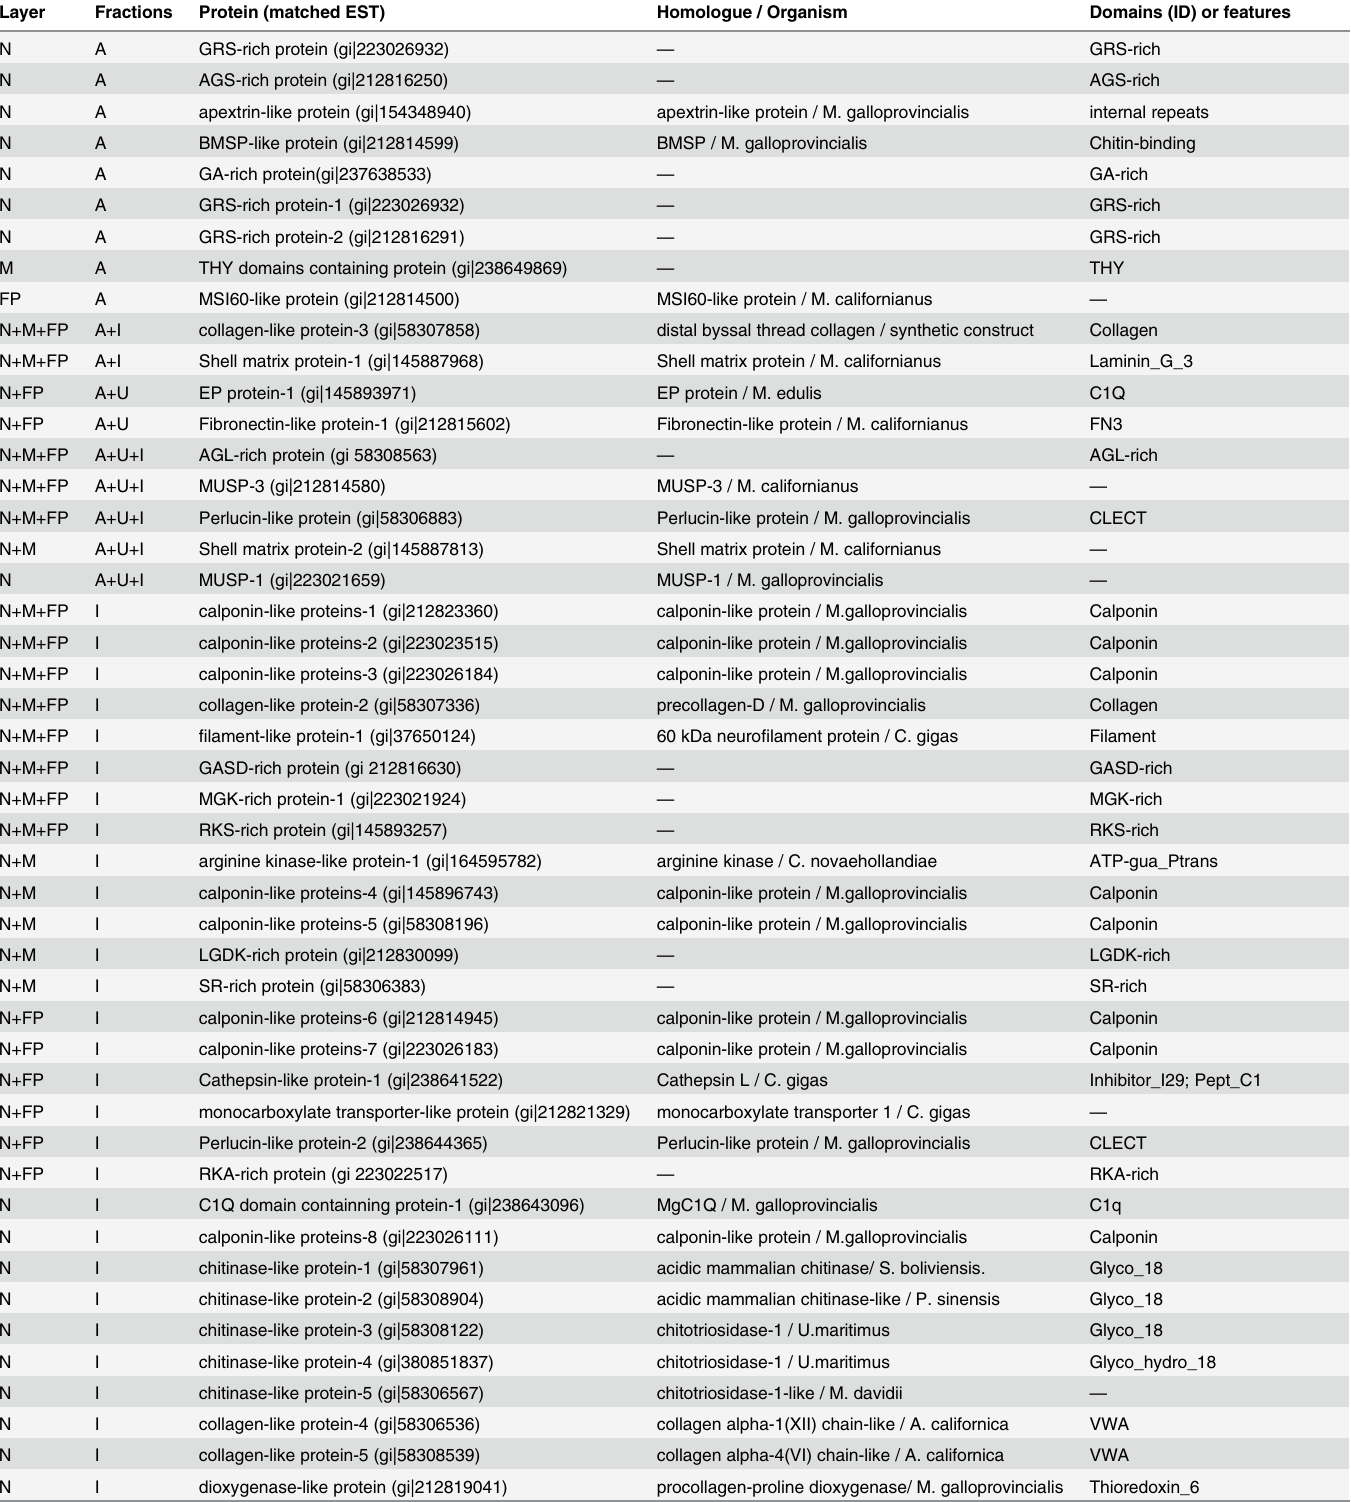
Table 1. The proteome of nacre (N), myostracum (M), and fibrous prism (M) of M . galloprovincialis shell.